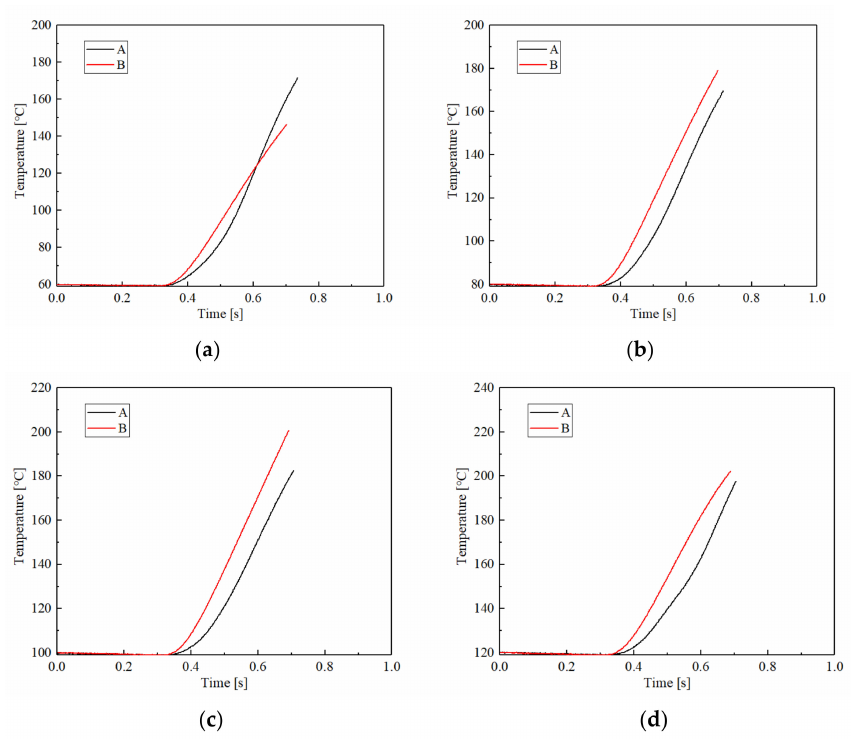
Figure 11. The temperature changes of samples A and B at different ATF temperatures: ( a ) 60 ◦